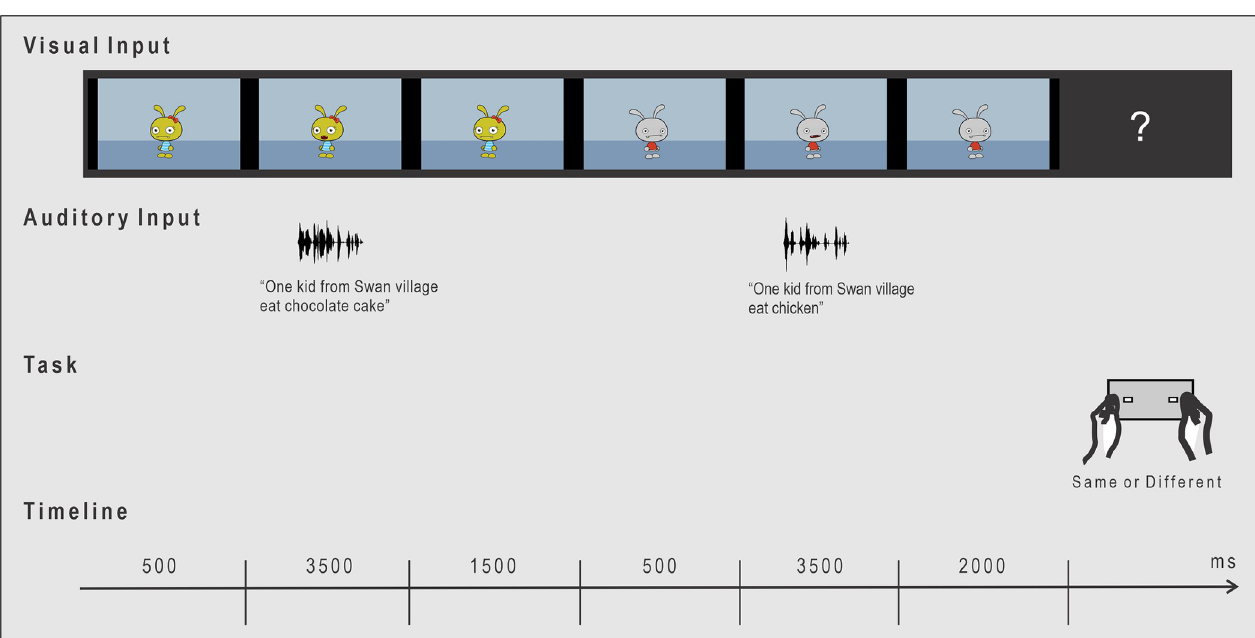
Fig 3. Trial sequence in the auditory ERP experiment. The appearance of the female cartoon character on the computer screen marked the beginning of each trial. After a participant gave his or her response to the task, a blank screen appeared for 2000 ms before the next trial